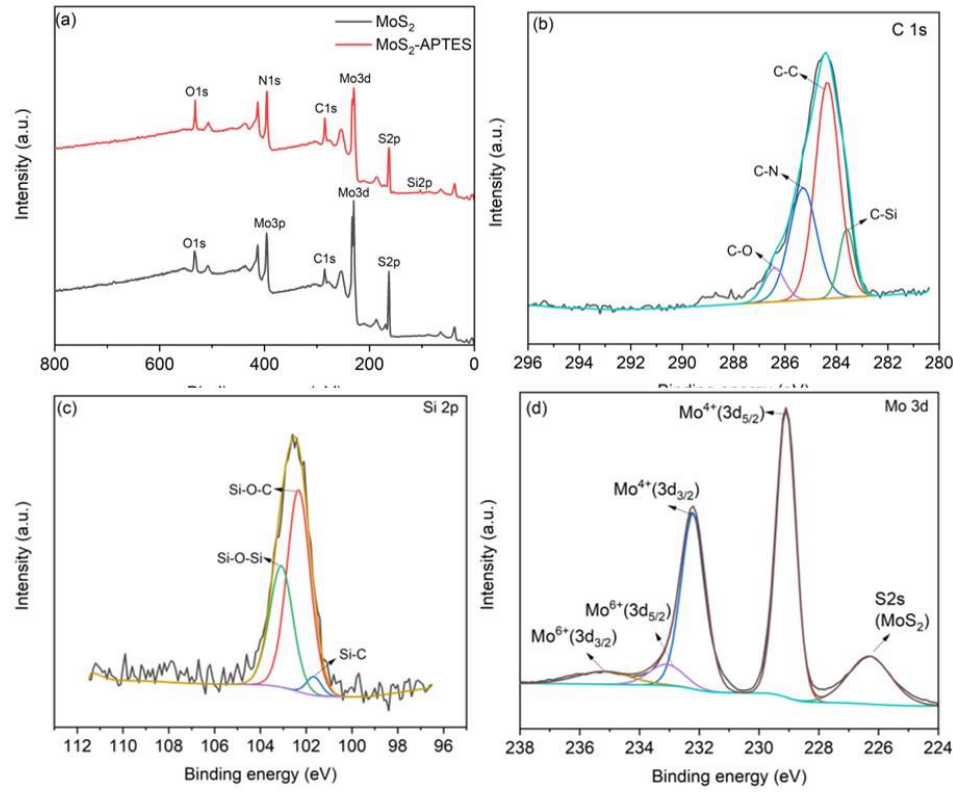
Figure 4. ( a ) Wide XPS survey of MoS 2 and MoS 2 -APTES and high-resolution spectra in ( b ) C 1s; ( c ) Si 2p and ( d ) Mo 3d binding energy regions of MoS 2 -APTES.